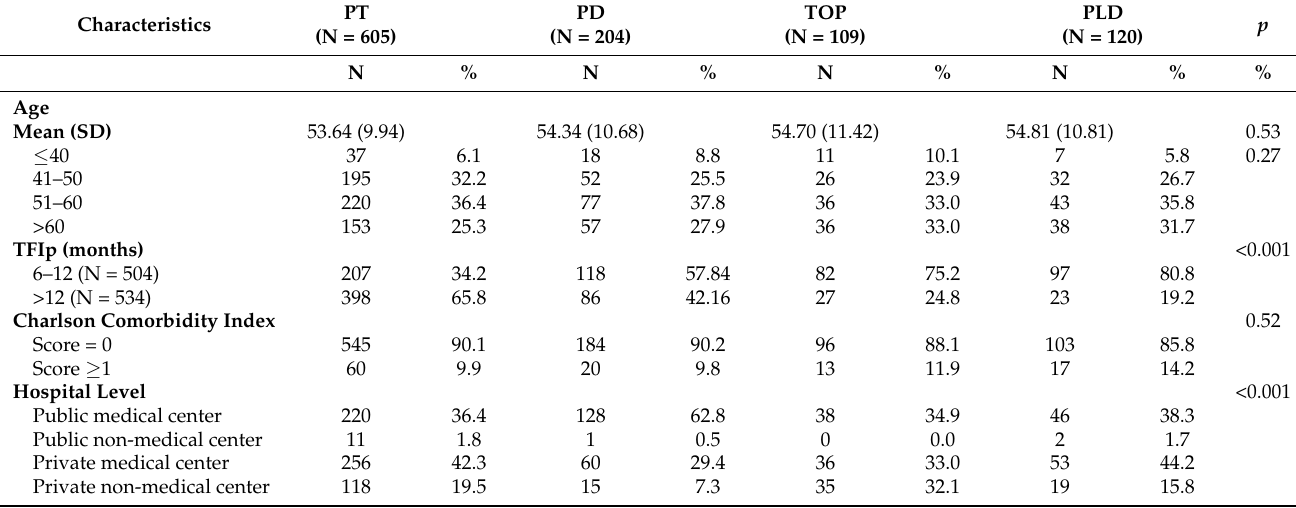
Table 1. Characteristics of 1038 recurrent advanced-stage EOC patients.